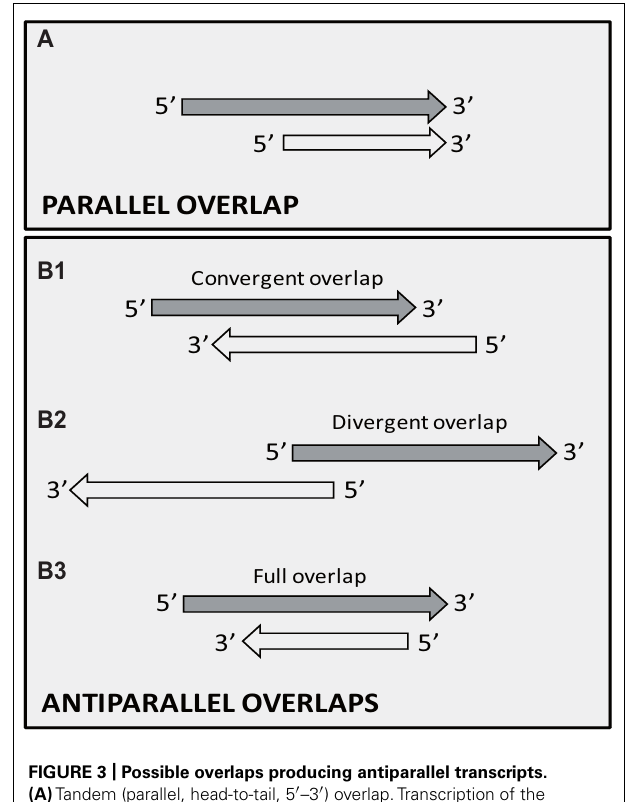
FIGURE 3 | Possible overlaps producing antiparallel transcripts. (A) Tandem (parallel, head-to-tail, 5 (cid:2) –3 (cid:2) ) overlap.Transcription of the upstream genes of a tandem gene cluster often fails to stop at their poly(A) signal, thereby producing long polycistronic RNA molecules. (B) Convergent (antiparallel) overlaps . ( B1 ) Head-to-head (5 (cid:2) –5 (cid:2) ) overlap between two divergently positioned genes. ( B2 )Tail-to-tail (3 (cid:2) –3 (cid:2) ) overlap between convergently oriented genes.Two opposing genes can overlap at their 3 (cid:2) -UTR regions (a) or can exhibit a 3 (cid:2) -UTR–ORF (b), or ORF–ORF overlap. ( B3 )Transcriptional read-through overlap occurs when the major poly(A) signal occasionally fails to terminate by the advancing RNAP (a). The use of alternative polyadenylation provides a mechanism similar to that of transcriptional read-through for the spatiotemporal control of gene expression